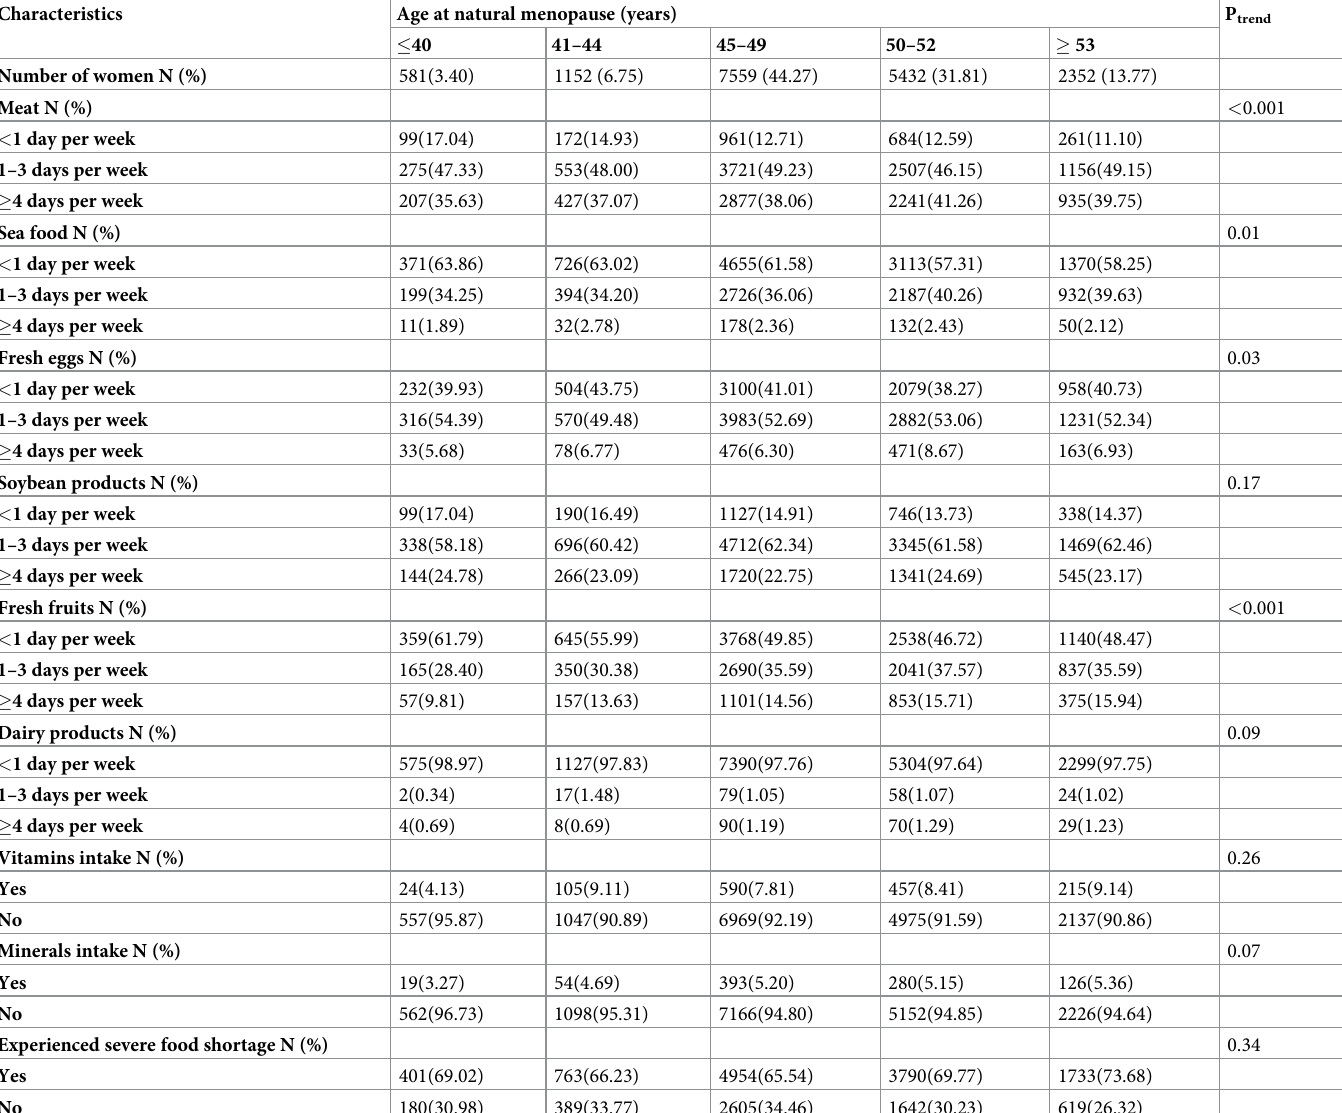
Table 3. Dietary characteristics of women according to age at natural